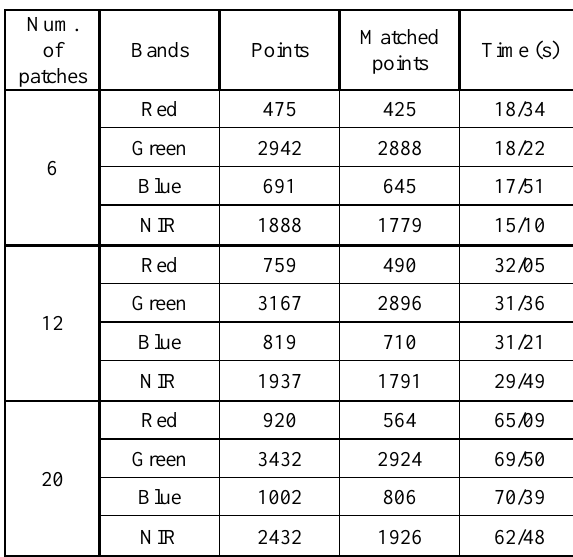
Table 1. Time, points, and matched points in different